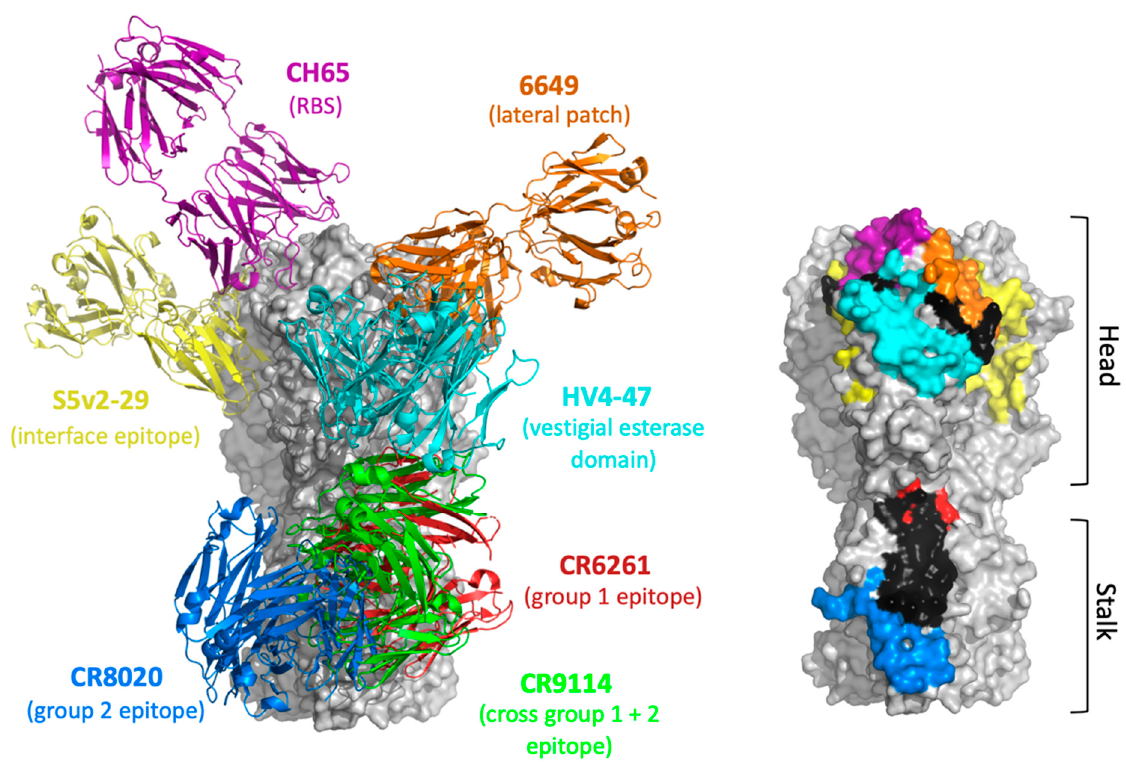
Figure 3. Broadly neutralizing epitopes on hemagglutinin (HA). Shown are (left) monoclonal antibodies (mAbs) and (right) their binding sites, defined by residues with atoms within 5A of their respective mAbs, modeled onto HA PBD 1RU7. Coloring between the modeled mAbs and binding sites are consistent with CR6261 (red, Group 1 epitope), CR9114 (green, Cross-Group 1 + 2 epitope), CR8020 (blue, Group 2 epitope), S5v2-29 (yellow, interface epitope), CH65 (purple, receptor binding site (RBS)), 6649 (orange, lateral patch), and HV5-47 (cyan, vestigial esterase domain). Binding sites are shown on a single protomer for all mAbs except for S5v2-29, which is shown on two protomers, since the site is hidden in this view of the single protomer. Residues which were composed of two or more binding sites are shown in black, while those not within any binding sites remain in gray. Head and stalk domains are labeled accordingly.